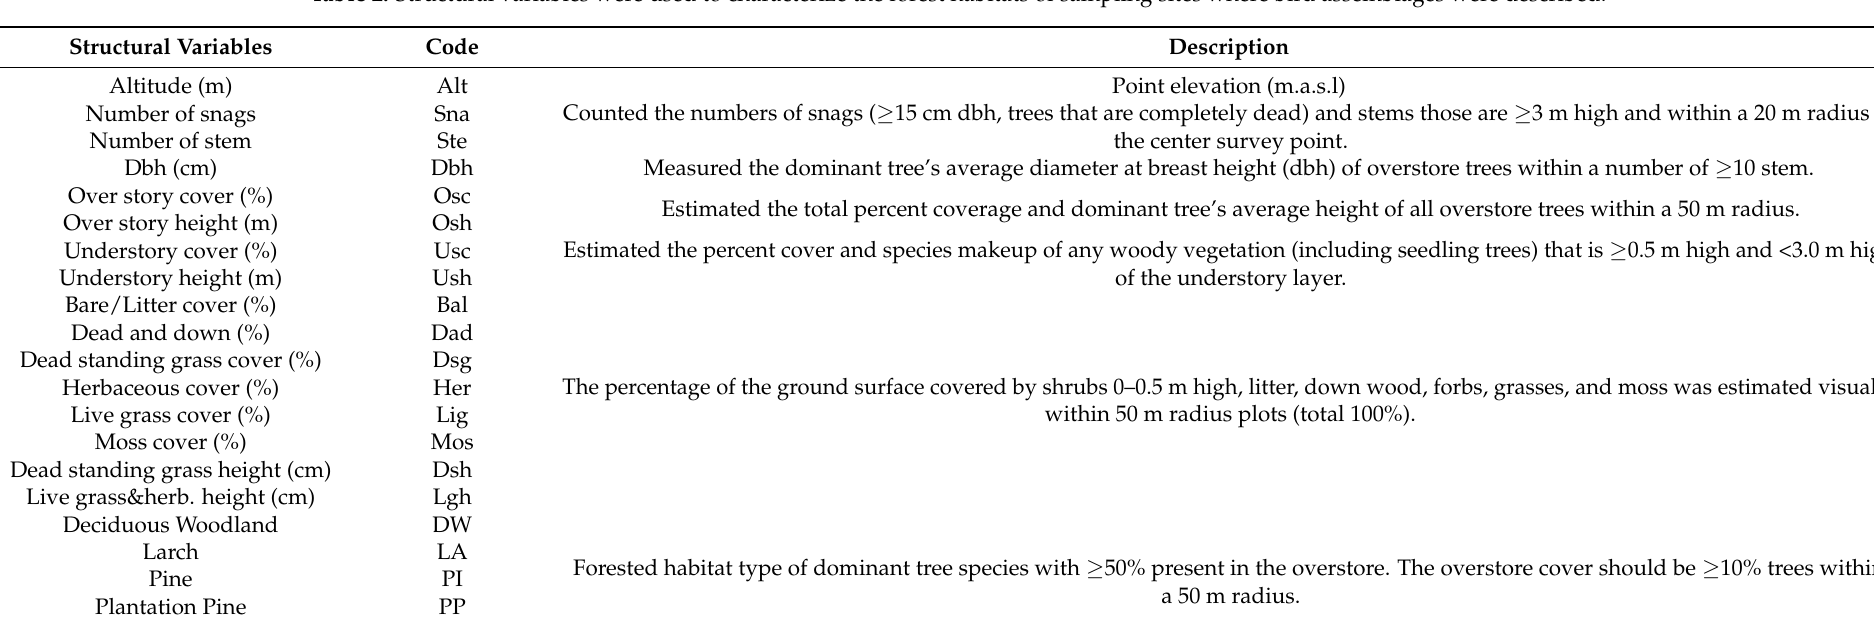
Table 2. Structural variables were used to characterize the forest habitats of sampling sites where bird assemblages were